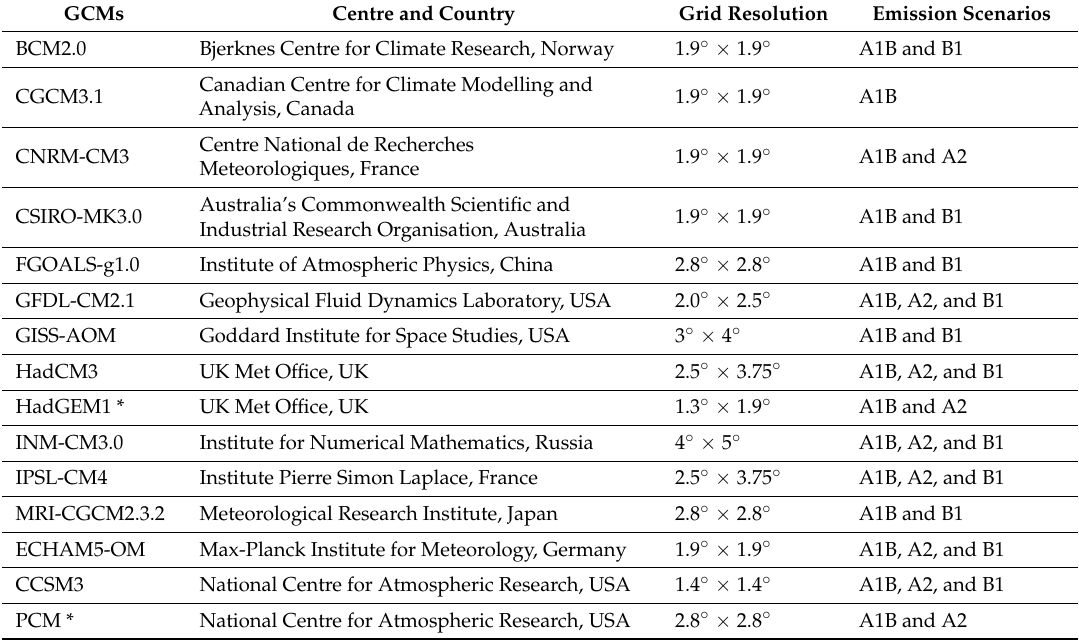
Table 1. Summary of selected general circulation models (GCMs) used in this study.